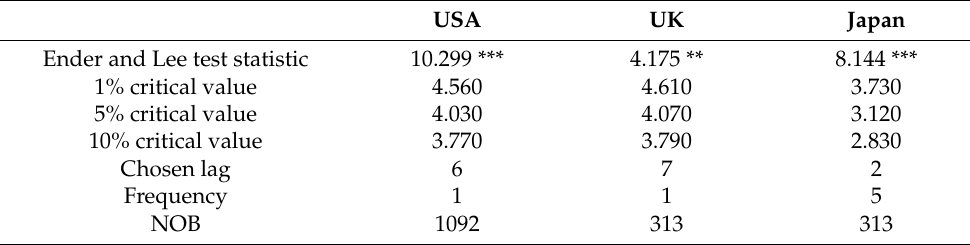
Table 10. Multiple-break unit root tests: Ender and Lee test.